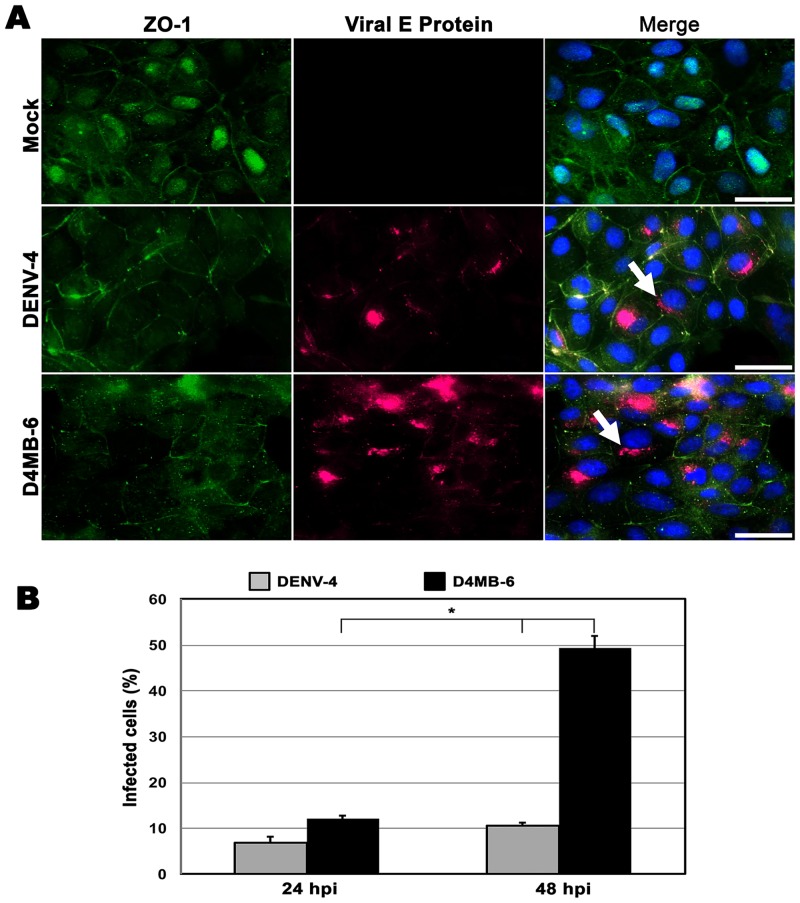
MBEC susceptibility to DENV infection.(A). MBEC cultured on glass coverslips were inoculated for 48 h with mock suspension or infected with DENV-4 or D4MB-6 at an MOI:1 and stained for detecting viral envelope protein (red) and ZO-1 protein (green). Both viruses infected the MBECs and showed perinuclear localization of viral E protein (arrow). On the other hand, the typical plasma membrane localization pattern of ZO-1 was detected in the mock and DENV-4 infected cultures, while in the D4MB-6 infected cells was located mainly in the cytoplasm, in clusters or in a discontinuous pattern in the perimembrane region. Bar = 20 μm. (B). Infection percentages of MBEC after 24 or 48 h p.i. Infection proportion was significantly higher with D4MB-6 at 48 h p.i. (49%), with regard to 11% of the cells infected with DENV-4. Data are shown as the mean +/- SD of 3 independent cultures performed by duplicate.